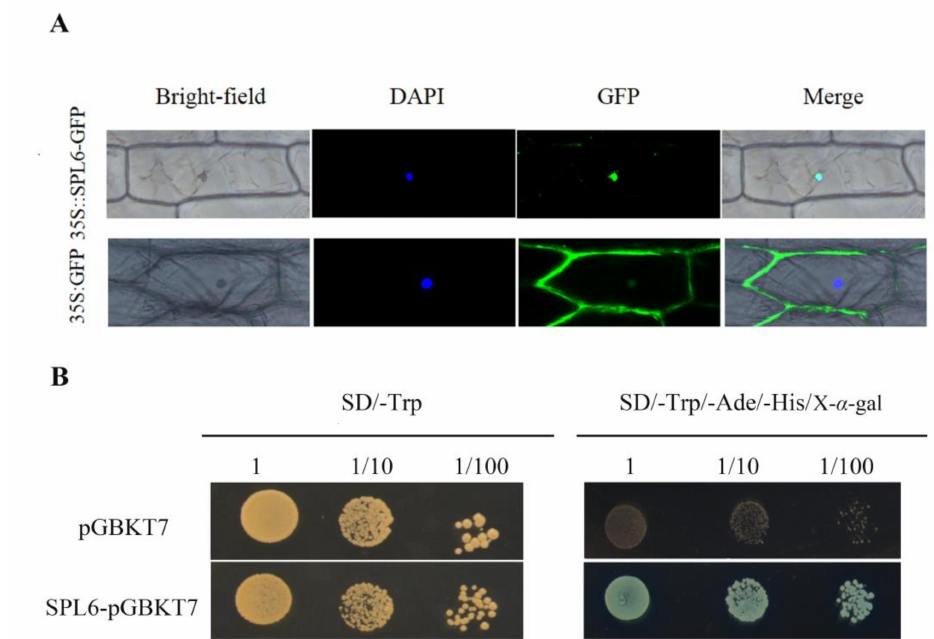
Figure 3. Subcellular location and transcription activity analysis of Sm SPL6 protein. ( A ) Subcellular location of Sm SPL6. The fluorescence signal was observed via laser scanning confocal microscope. DAPI, 4 (cid:48) , 6-diamidino-2-phenylindole is a blue fluorescent DNA stain that was used for indicating nucleus region. ( B ) Transcription activity analysis of Sm SPL6 protein. Yeast colonies with three different dilutions were grown on the SD/-Trp medium, then spotted on the SD/-Trp/-Ade/-His/X- α -gal. X- α -gal: 5-Bromo-4-chloro-3-indolyl- α -D-galactoside medium, the color reaction substrate of α